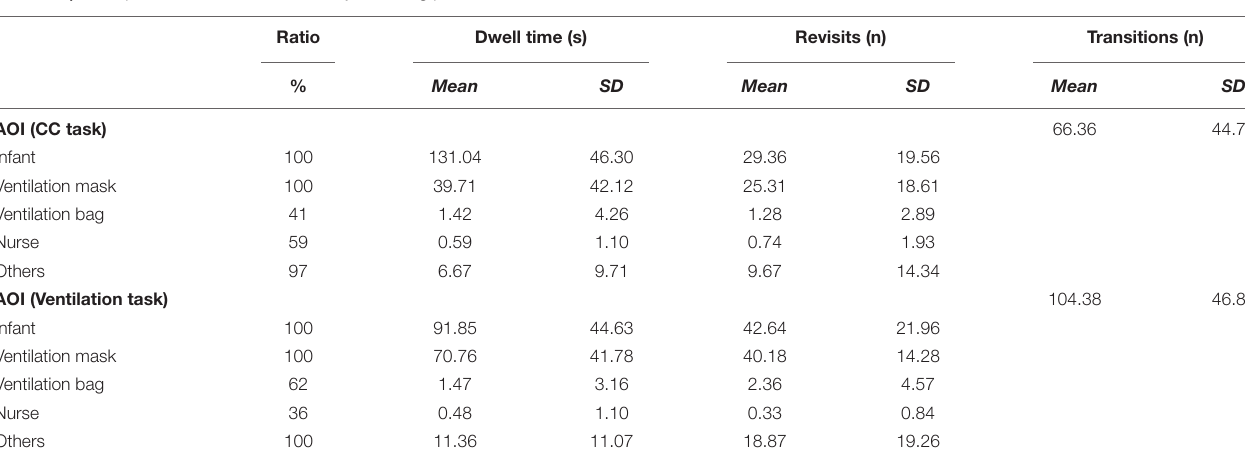
FIGURE 1 | Snapshots showing visual attention (red circle) of participants during the chest compression scenario (A) and the ventilation scenario (B) . TABLE 1 | Descriptive statistics of the tested eye-tracking